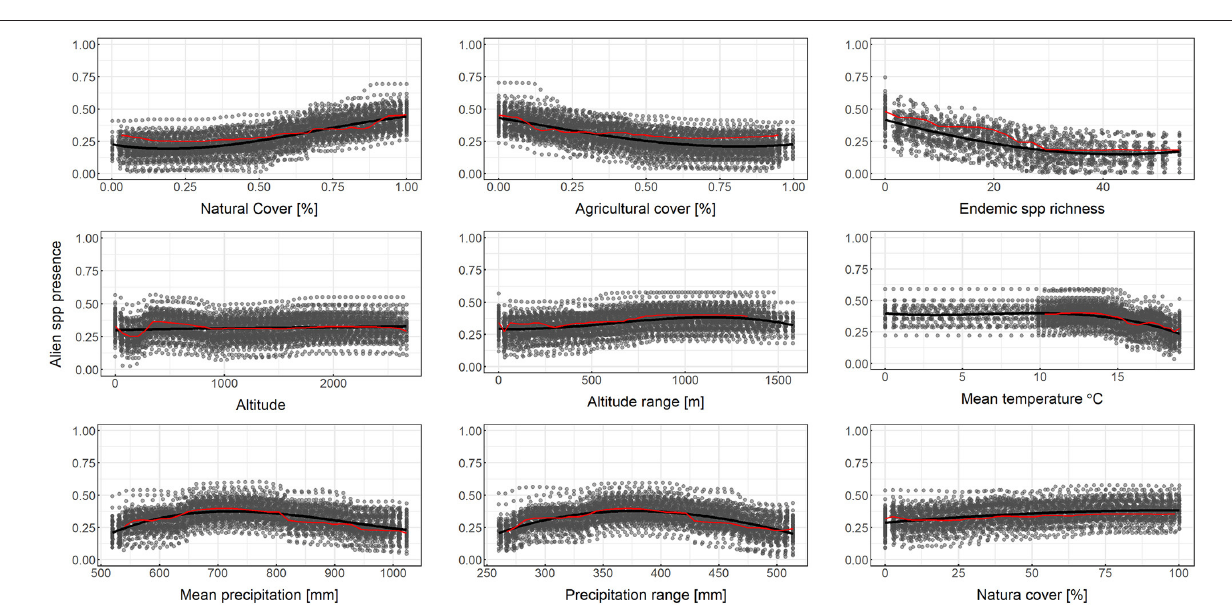
FIGURE 3 | Partial dependence plots for selected independent variables for random forest downscaling of alien species presence. Y-axis is on the logit scale. Here 3rd degree polynomial splines (solid black lines) are fitted over the output the Monte Carlo runs (gray points). Red lines connect points from a single random sample of the bootstrap